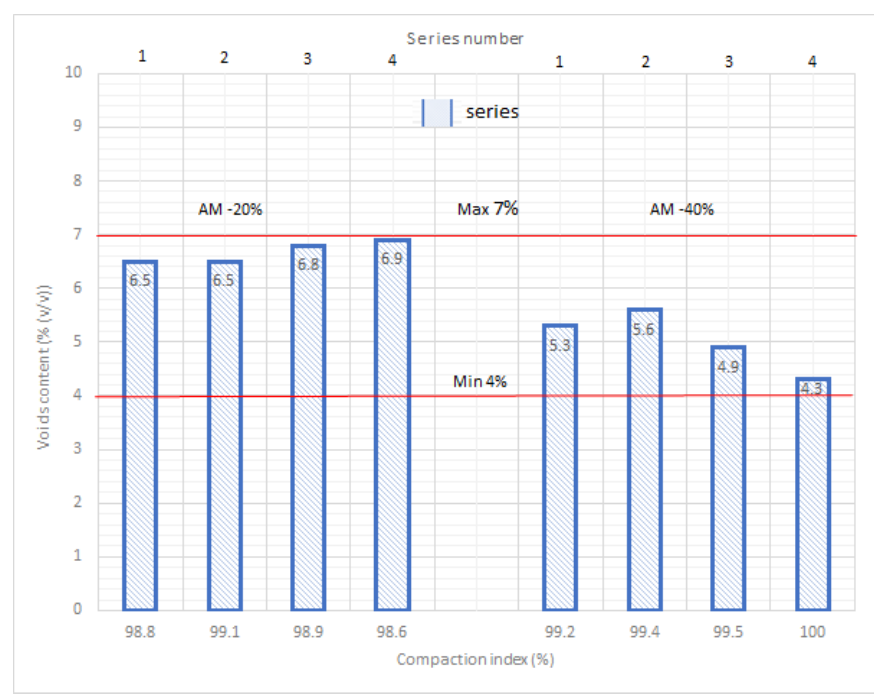
Figure 6. Lab tests results for samples from trial sections of AM-20% and AM-40%.